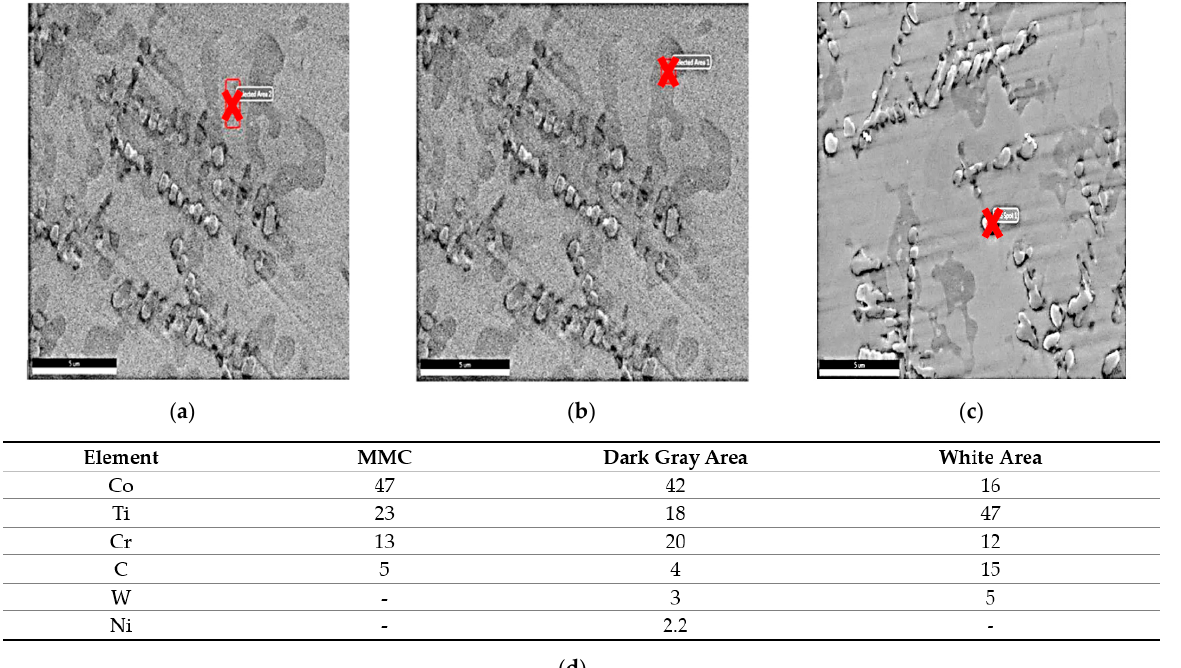
Figure 6. SEM micrographs and EDAX point analysis results of the deposited layer made with 100% stellite-6 powder: ( a ) gray, ( b ) dark gray, ( c ) white, and ( d ) the chemical analysis results for each color.